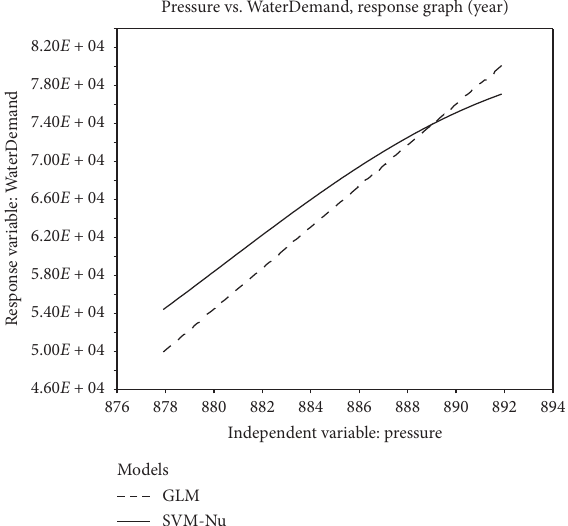
Pressure vs. WaterDemand, response graph (year)